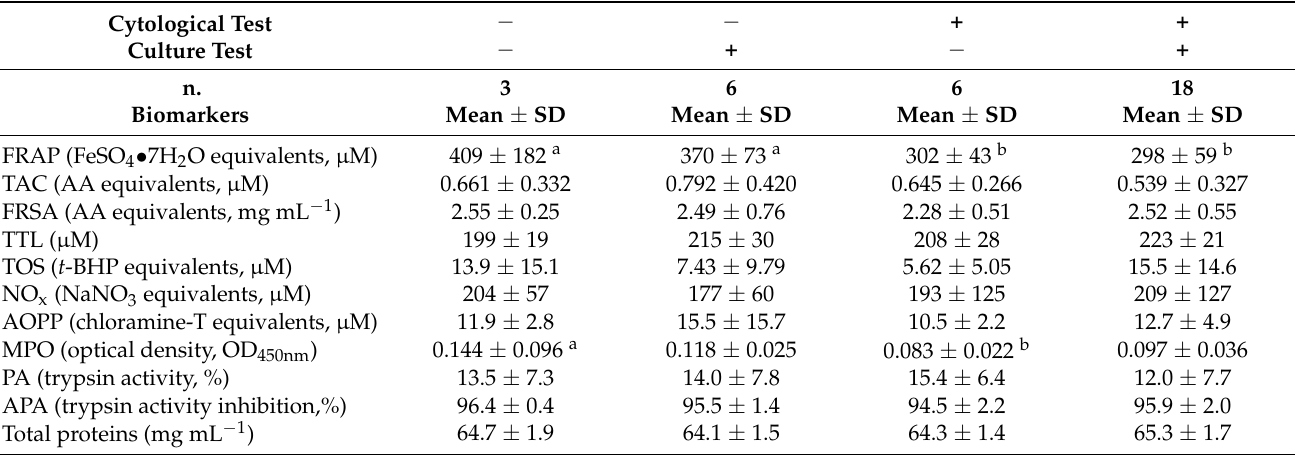
Table 3. Mean ( ± SD) values of oxidative, inflammation, and protease regulator biomarkers assessed in the blood serum of mares with negative and positive outcomes for the diagnosis of endometritis based on either microbiological or cytological